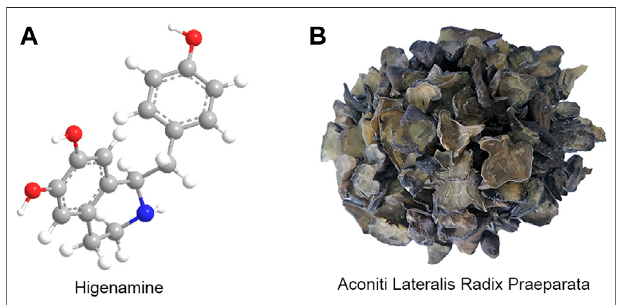
FIGURE 1 | The chemical structure of higenamine (A) and the prepared slices of ALRP (Heishunpian) (B) .